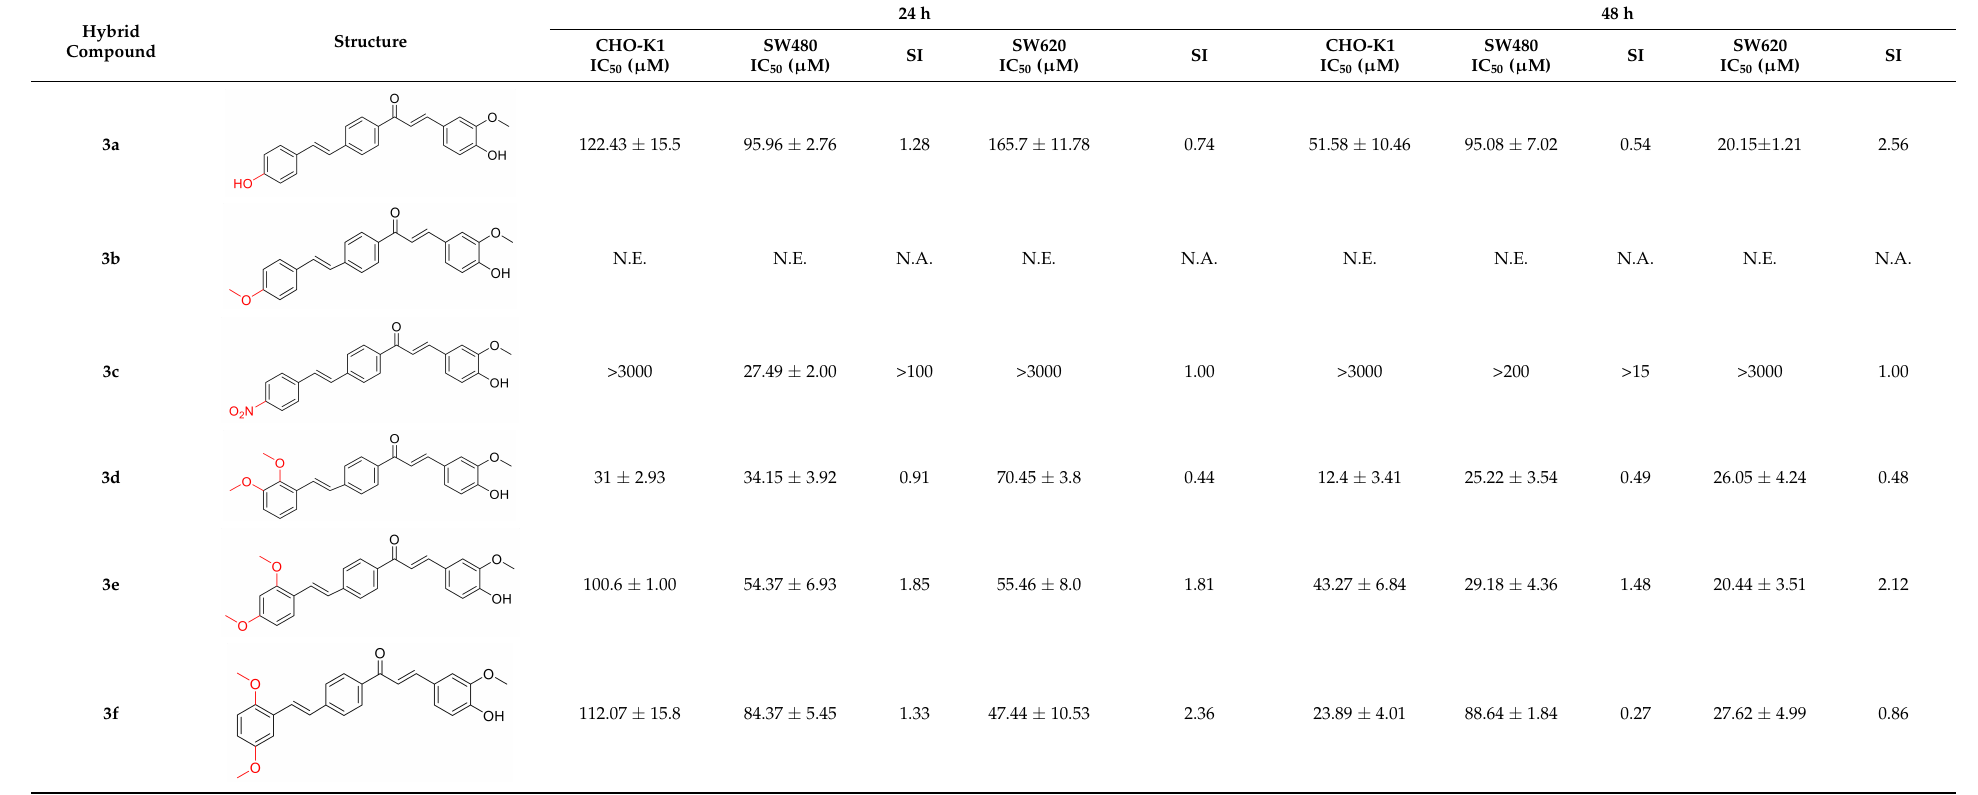
Table 1. Cytotoxic effect of the hybrids against SW480, SW620 and CHO-K1 cell lines at 24 and 48